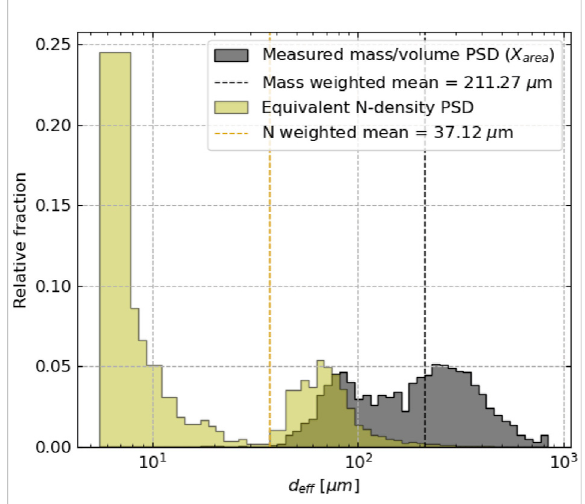
FIGURE 6 Particle size distribution (PSD) measured in the ash sample collected with the RPAS on 11 September 2019. [grey] Original measurement from Camsizer. Volumetric fraction of the particles with regards to their equivalent diameter ( X area : diameter of the area equivalent circle of each particle projection), yielding a mass fraction PSD with a mean at 211.17 μ m. [yellow] Number density PSD, where the relative fraction is based on the number of particles instead, converted from volumetric fraction assuming spherical particles. N-density PSD is heavily skewed towards smaller particles (mean of 37.12 μ m) and is more directly comparable with retrieved sizes in this